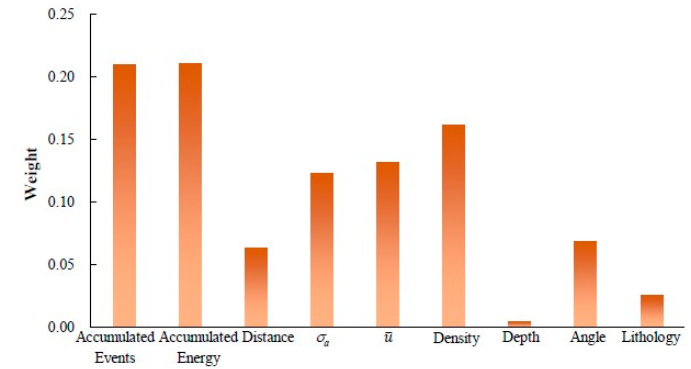
Figure 8. The weight of the nine evaluation indexes.